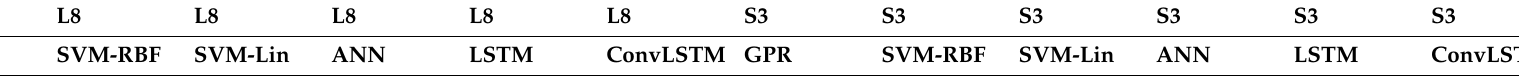
Table 3. Post-Hoc Scheffe test p -values for all 12 groups’ two level factors (Satellite Type * ML Algorithm) for